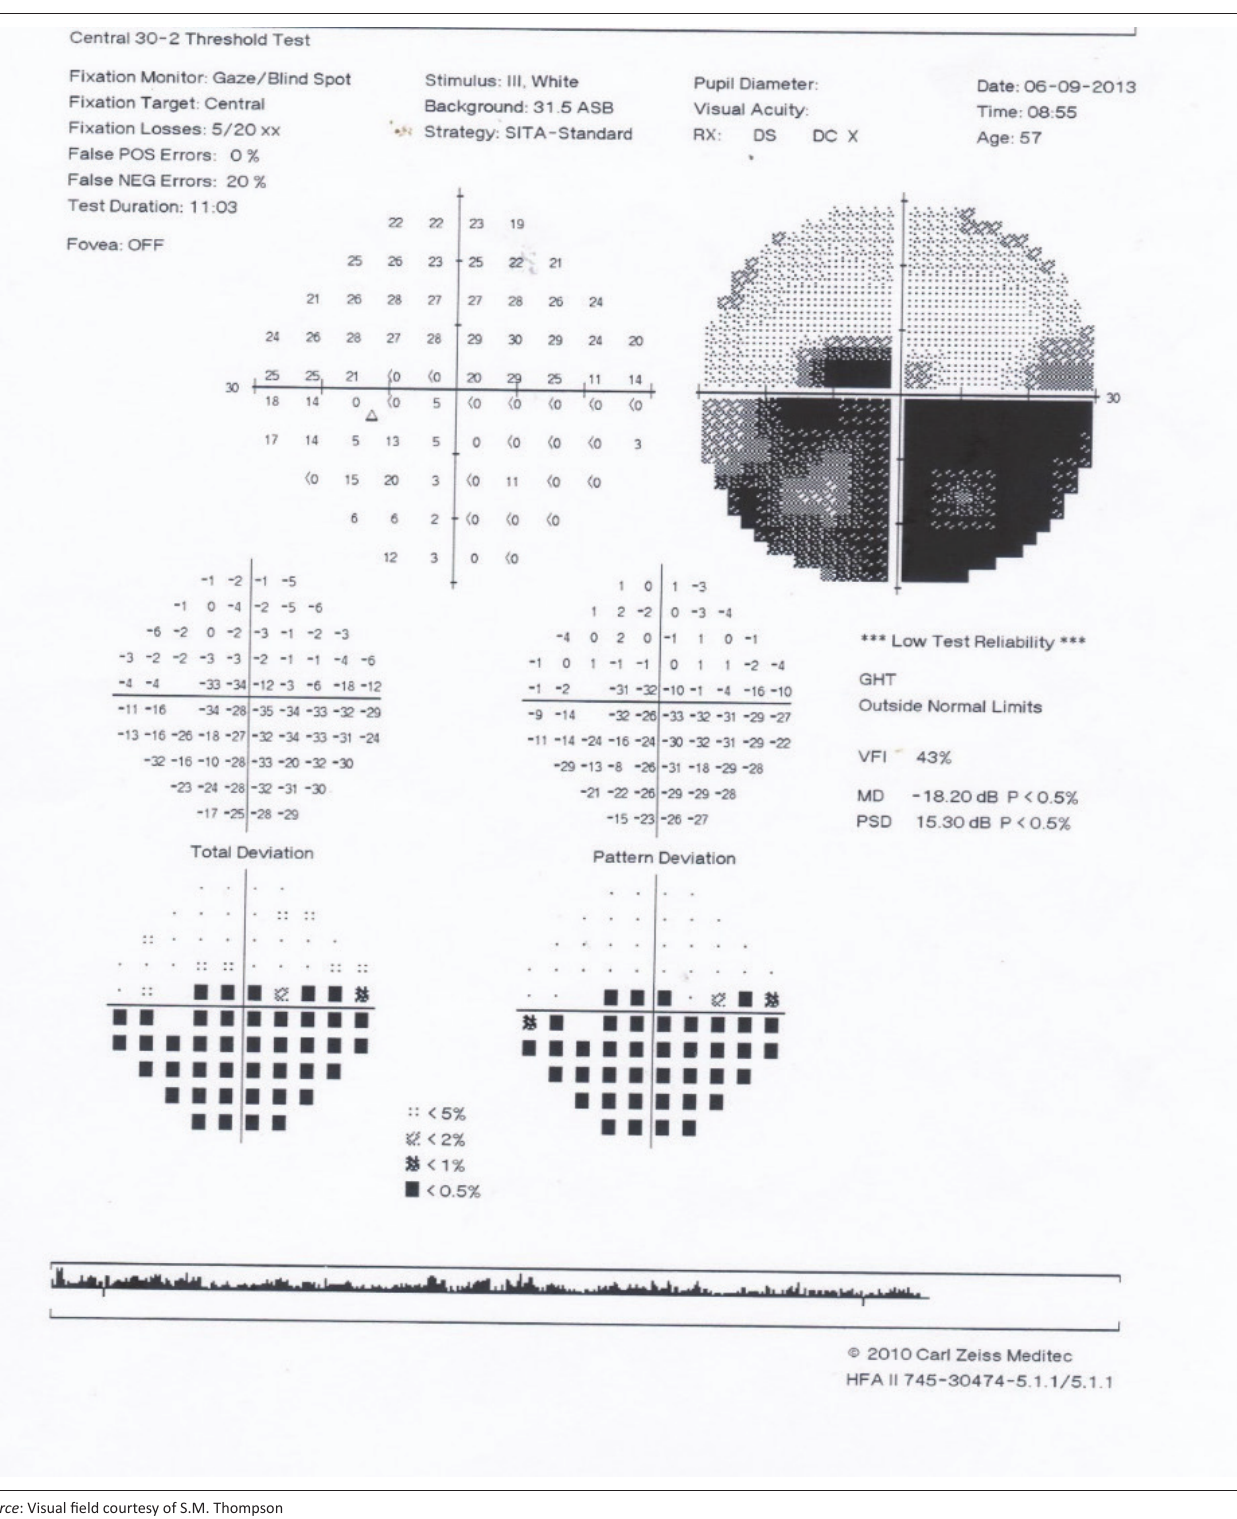
FIGURE 2: Humphrey Visual Field Test (Central 30-2 threshold) for the left eye suggests a mainly inferior altitudinal or hemi-field visual field defect that might extend even further outwards. Note the result for the fixation losses (5/20), which indicates possible intratest unreliability or difficulties with central fixation or unstable eye movement, possibly because of the visual field loss affecting the foveal or central region of the visual field. The patient might be seeking the vision stimuli by moving the eye about rather than maintaining steady fixation (see also the gaze tracking record below the visual field and compare with